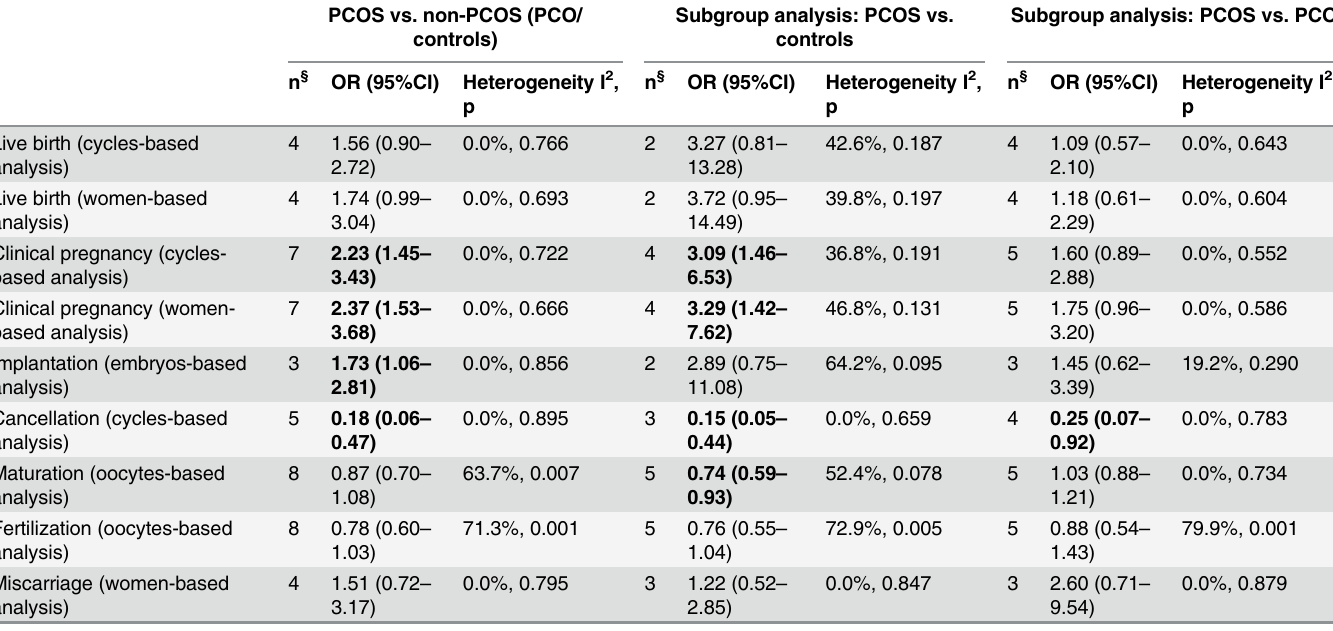
Table 3. Results of the meta-analyses addressing the three comparisons (PCOS vs. controls; PCO vs. controls; PCOS vs. PCO) in the examined outcomes (Bold cells denote statistically significant associations). PCOS vs. non-PCOS (PCO/ Subgroup analysis: PCOS vs. controls)